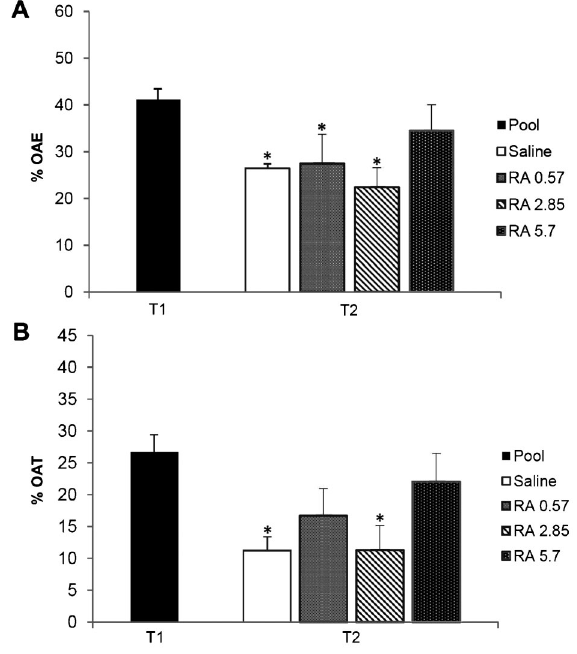
Figure 3. Effects of H2 antagonist ranitidine (RA; 0.57, 2.85, or 5.7 nmol/0.1 m L) microinjected into the cerebellar vermis on A , the percentage of open-arm entries (%OAE) and B , the percentage of time spent in the open arms (%OAT) in Trials 1 and 2 in the elevated plus maze. Pool: animals exposed to the elevated plus maze with no pharmacological treatment. Data are reported as means± SE (n=9-12). *P , 0.05 Trial 2 vs Trial 1 (Duncan test).